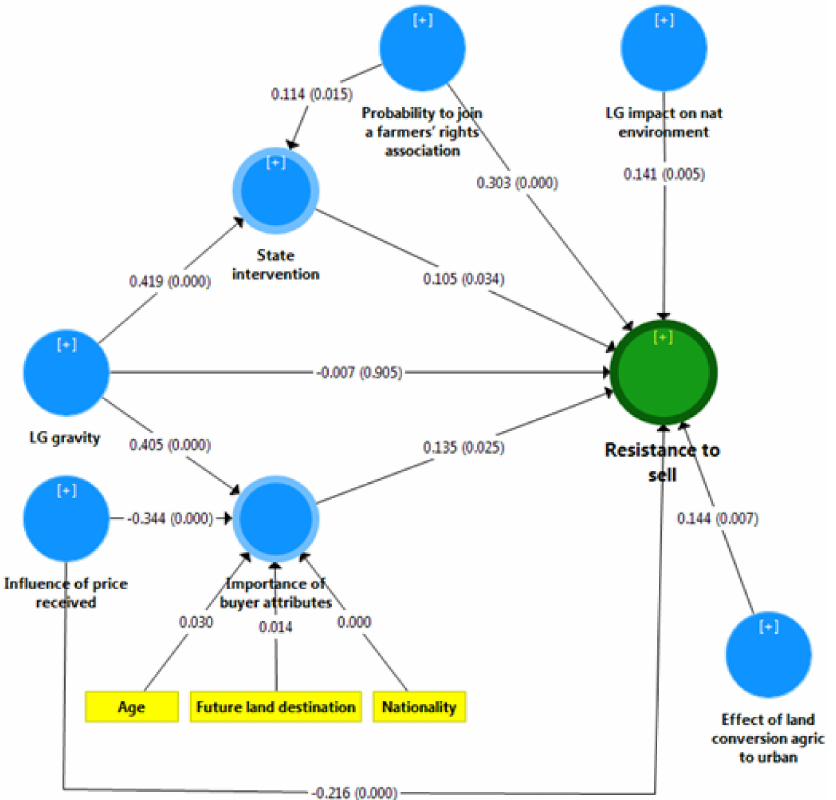
Figure 3. Path coefficients and p -values (between brackets) in the structural model designed to predict landowners’ “Resistance to